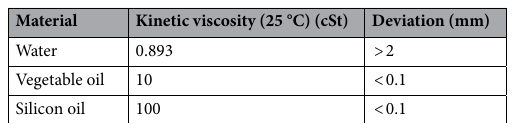
Table 1. Kinetic viscosity and the deviation from the initial position after 50 compression processes.